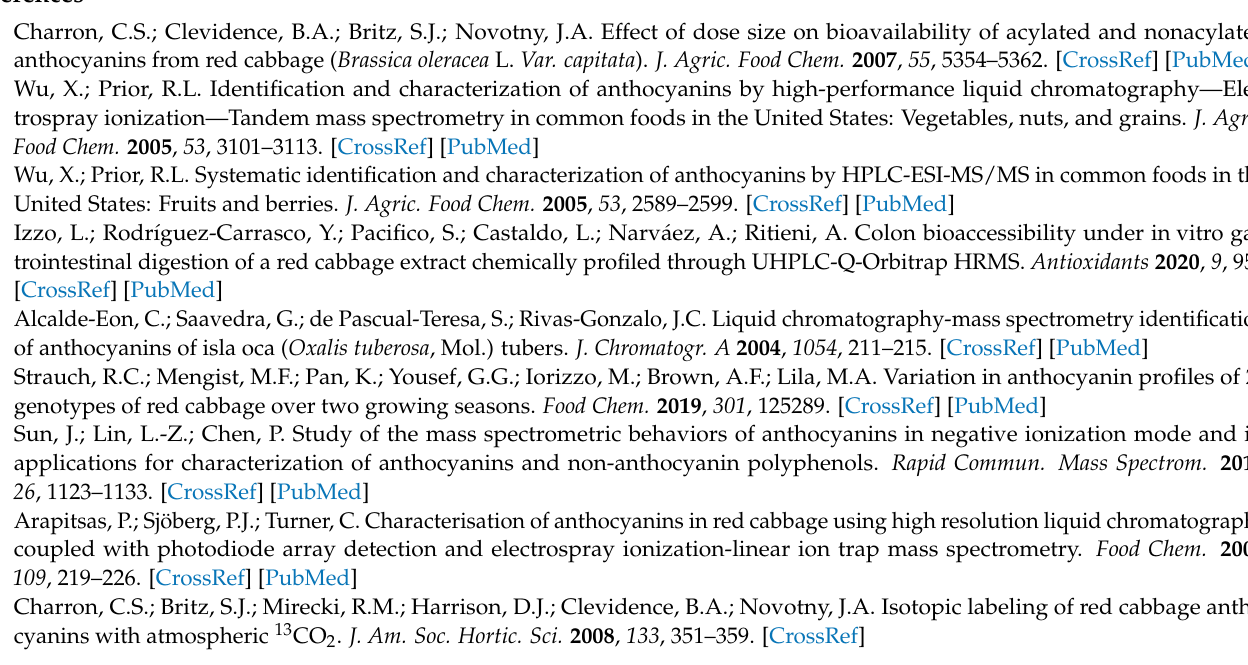
phenolic extract. Figure S2. UPLC-MS chromatogram (negative ESI) of the red cabbage phenolic extract. Figure S3. Total antioxidant capacity (TAC) of the total alcoholic extract and the phenolic extract of red cabbage leaves calculated for 4 min at 593 nm. Figure S4. Antimicrobial activity of the total alcoholic extract and the phenolic extract of red cabbage leaves against Staphylococcus aureus, Bacillus subtilis, Escherichia coli, Pseudomonas aeruginosa, Candida albicans and Aspergillus niger compared to standard Ampicillin, Streptomycin and Clotrimazole. The phenolic extract and all the standards were prepared as 100 µ g/mL. Figure S5. Anticancer activity of various concentrations of the total alcoholic extract and the phenolic extract of red cabbage leaves against the cervical cancer cell line; HeLa. Figure S6. Anticancer activity of various concentrations of the total alcoholic extract and the phenolic extract of red cabbage leaves against the breast cancer cell line; MCF-7. Figure S7. Anticancer activity of various concentrations of the total alcoholic extract and the phenolic extract of red cabbage leaves against the liver cancer cell line;